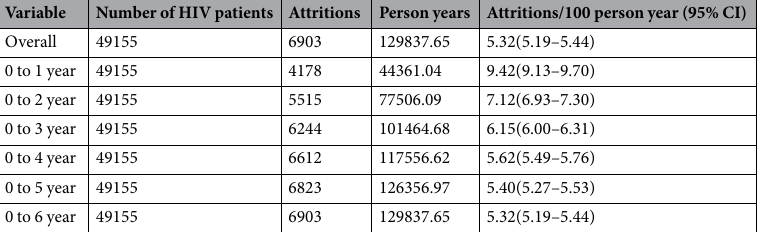
Table 3. Attrition rates in HIV-infected patients who started ART between 2010 and 2015 in Guangxi, China, by year post-ART initiation.